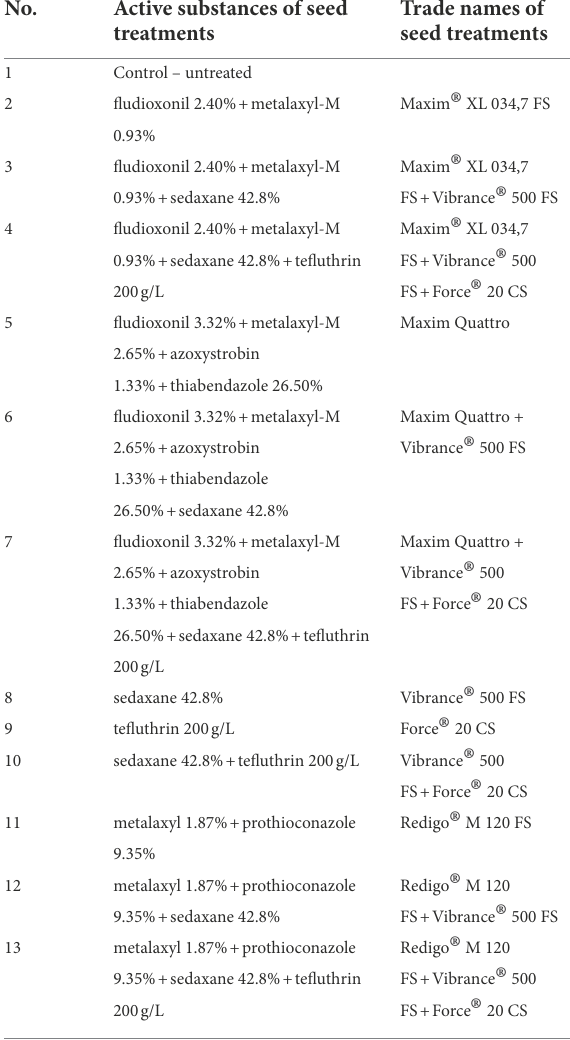
TABLE 1 Active substances and trade names of seed treatments used in experiment.